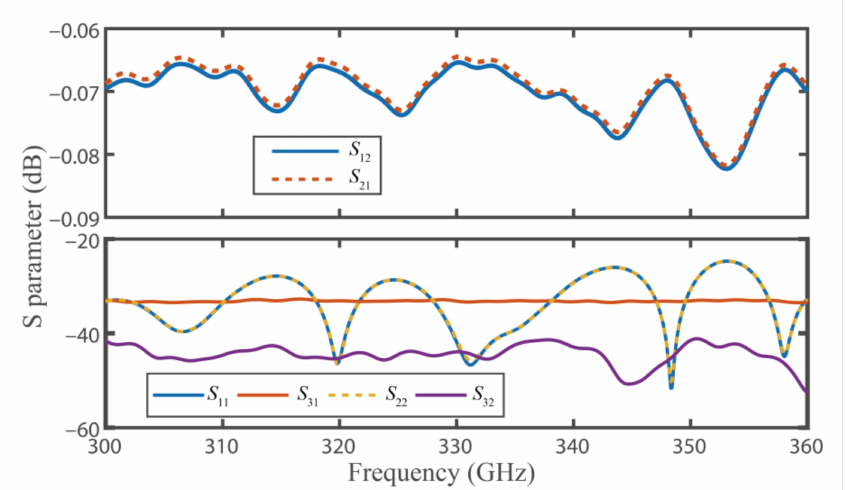
Figure 14. Simulation results of S 11 , S 21 , S 31, S 12 , S 22 , and S 32 parameters from 300–360 GHz, where S 21 is the transmission coefficient, S 31 is the coupling